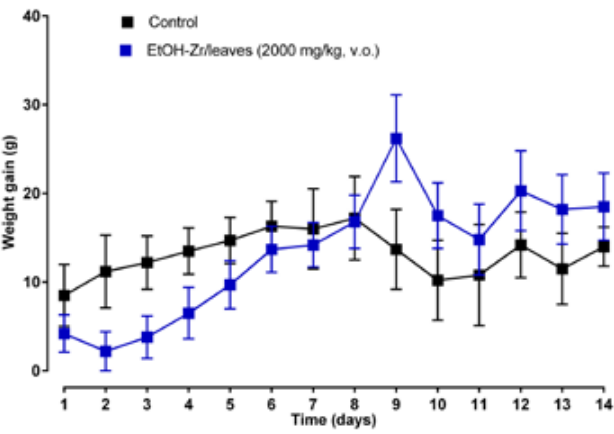
FIGURE 1 - Evolution of the weight of the animals of the control groups (■) and those treated with EEtOH-Zr / leaves 2,000 mg / kg (■). Data represented by mean ± standard error, n = 6 animals.